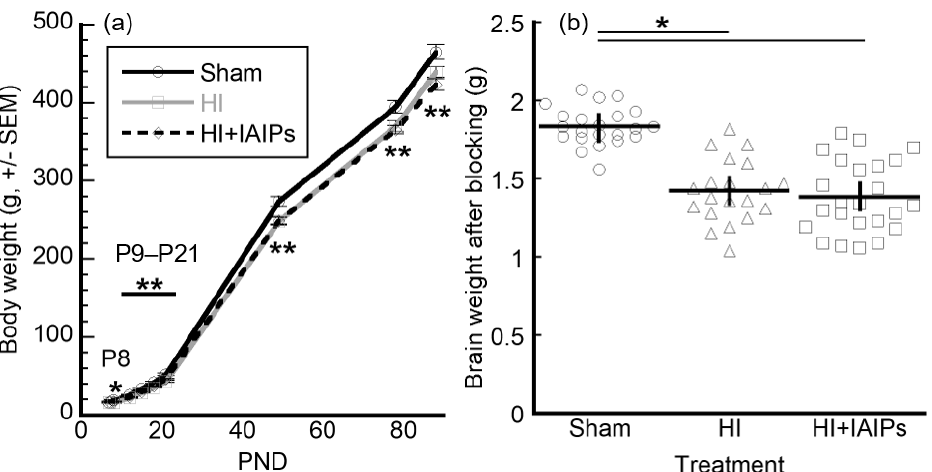
Figure 2. ( a ) Body weight of animals ( ± SEM) over time of study. Total n = 67 after surgery, Sham (22), HI (20), HI + IAIPs (25). Repeated measures ANOVA indicates an overall e ff ect of HI injury on body weight, * indicates that HI is significantly lighter than Sham and ** indicates both HI and HI + IAIP cohorts are significantly lighter than Sham animals. ( b ) Brain weights for Sham, HI, and HI + IAIPs subjects at time of collection. Horizontal bars are mean values and vertical bars indicate SEM. Total n = 66 after brain collection, Sham (22), HI (20), HI + IAIPs (24). ANOVA with Tukey’s homologous subsets indicate that brain weights were significantly lower in both injured treatment groups as compared to shams. HI = Hypoxic-Ischemic injury; IAIPs = Inter-alpha Inhibitory Proteins; PND = post-natal day.